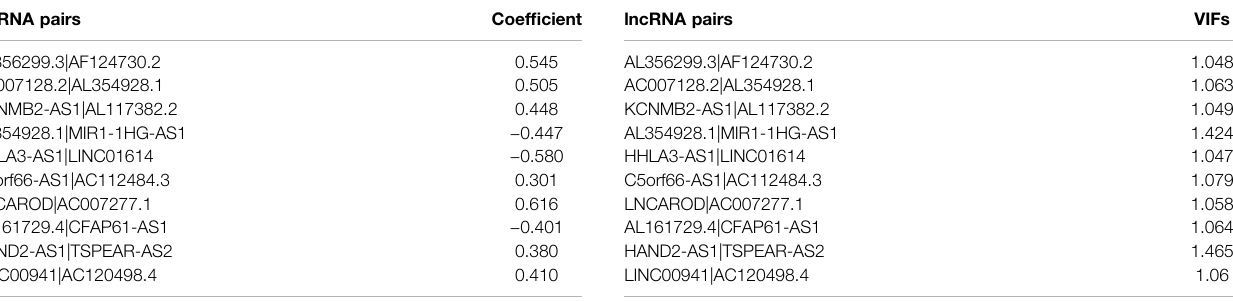
TABLE 3 | lncRNA pairs used for the construction of the FRLP risk score model. TABLE 4 | The variance in fl ation factors (VIFs) of 10 lncRNA